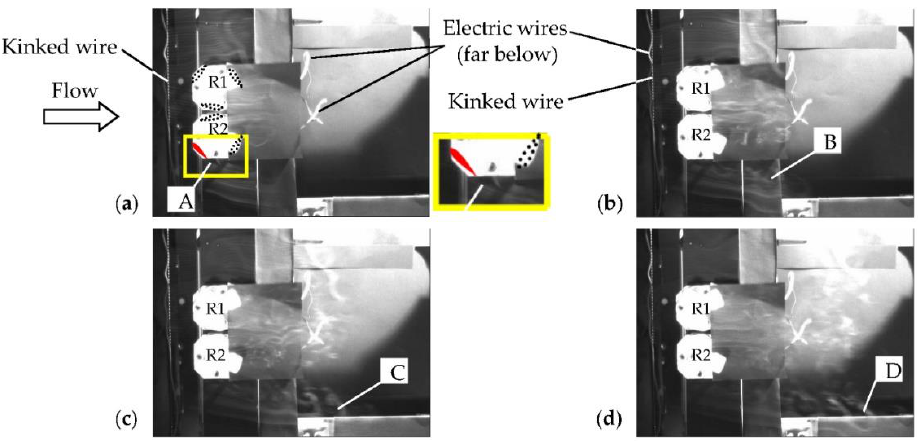
Figure 10. Photographs of smoke flow past two turbines at rest arranged side-by-side at g = 10 mm under V = 1 m/s: ( a ) t = 0.15 s; ( b ) t = 0.21 s; ( c ) t = 0.27 s; ( d ) t = 0.33 s.